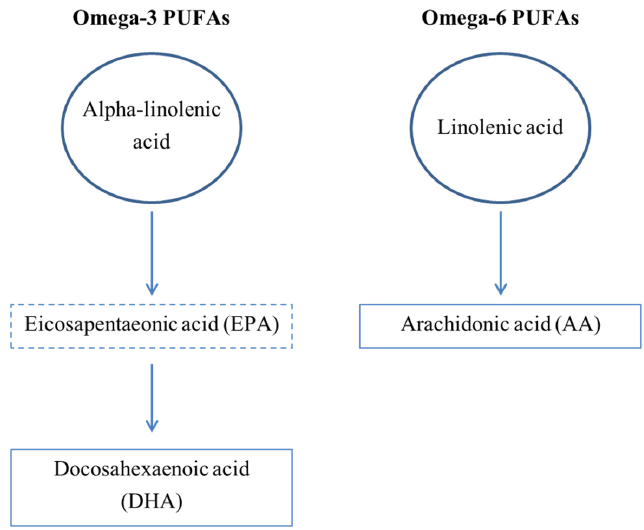
Figure 1. Subgroups of PUFAs. There are many members of the polyunsaturated fatty acid (PUFA) family; the most relevant to this discussion are shown in the above diagram. Arachidonic acid (C20:4) is derived from linolenic acid/omega-6 (C18:2). Docosahexaenoic acid (C22) derives from α -linolenic acid/omega-3 (C18:3) via the precursor eicosapentaeonic acid (C20:5).